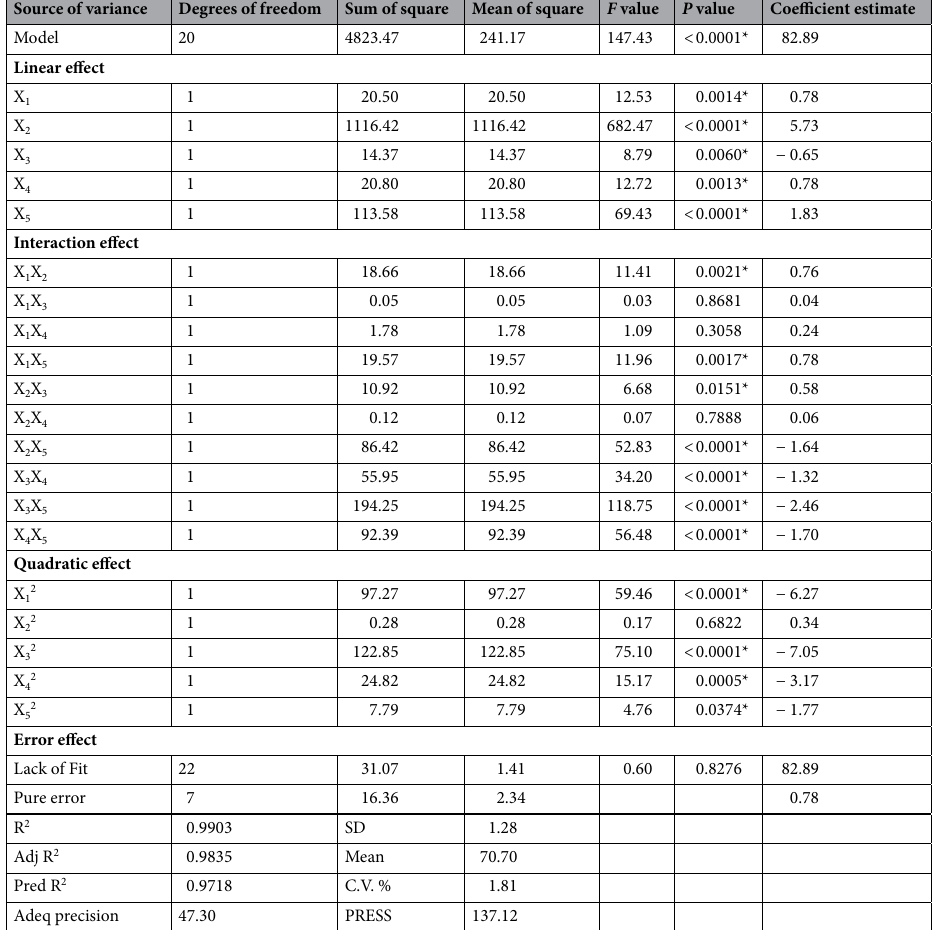
Table 2. Analysis of variance for biosorption of Remazol brilliant blue dye by using Gelidium corneum biomass obtained by FCCCD. F Fishers’s function, P level of significance, C.V coefficient of variation. *Significant